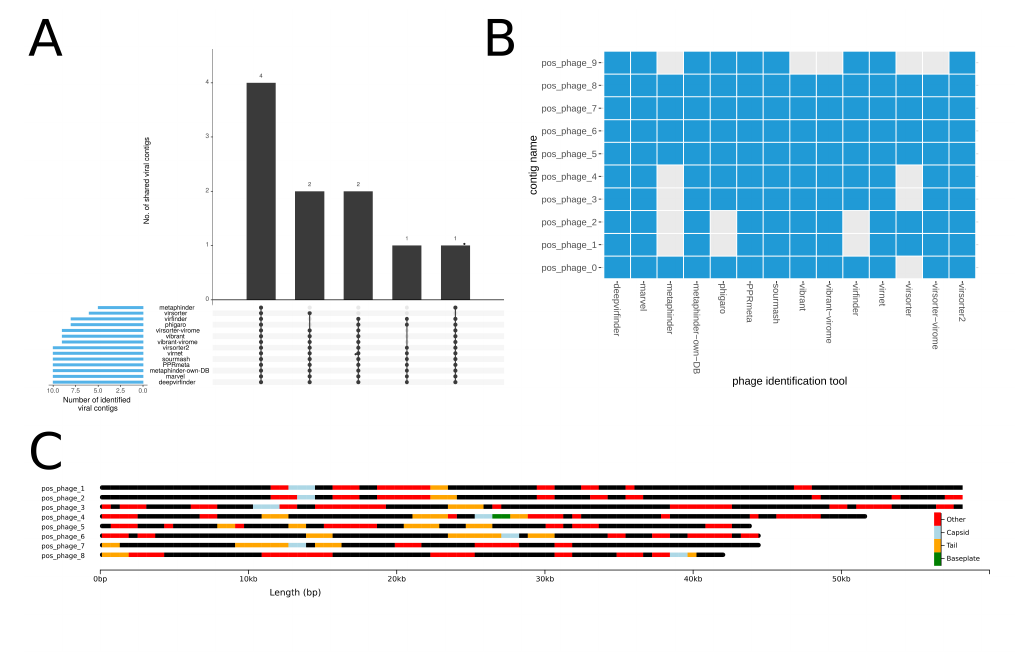
Figure 5. ( A ) The UpSet plot is summarizing the identification performance of each tool for a multi fasta sample. The total amount of identified phage-contigs per tool is shown in blue bars on the left. Black bars visualize the number of contigs that each tool or tool combination has uniquely identified. Each tool combination is shown below the barplot as a dot matrix. ( B ) Modified heatmap for phage sequences visualising the tool agreements per phage positive contig. ( C ) Visual annotation of phage contigs and annotated protein-coding genes via chromoMap. Annotations are coloured based on the categories of capsid genes (blue), tail genes (orange), baseplate genes (green) and other phage genes (red). For better readability, the contigs pos_phage_0 and pos_phage_9 were removed from the